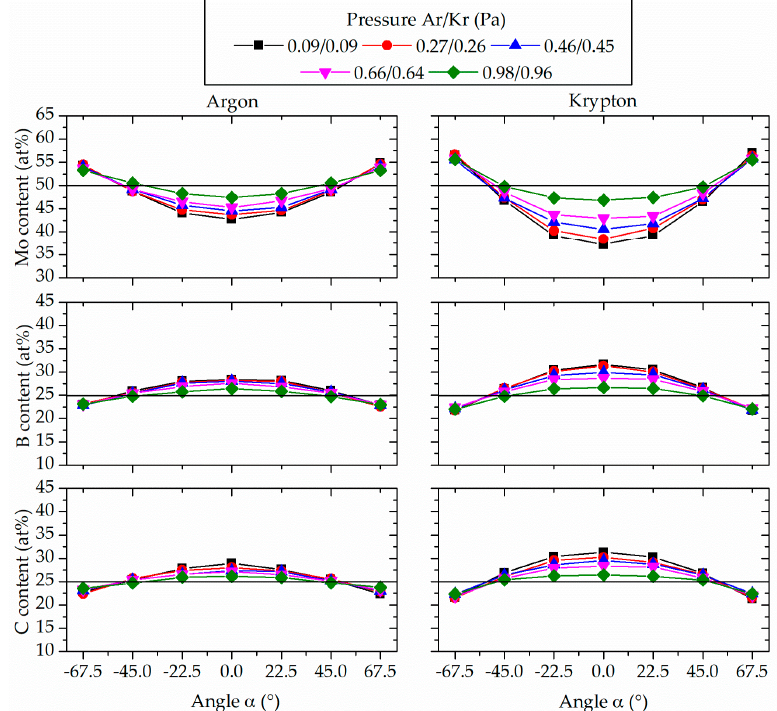
Figure 7. Angle-resolved evolution of simulated film compositions considering sputtering at the target, as well as scattering during gas phase transport. The first pressure value pertains to the Ar depositions, the second value to the Kr depositions. The ideal stoichiometric target composition is marked by the black horizontal lines.